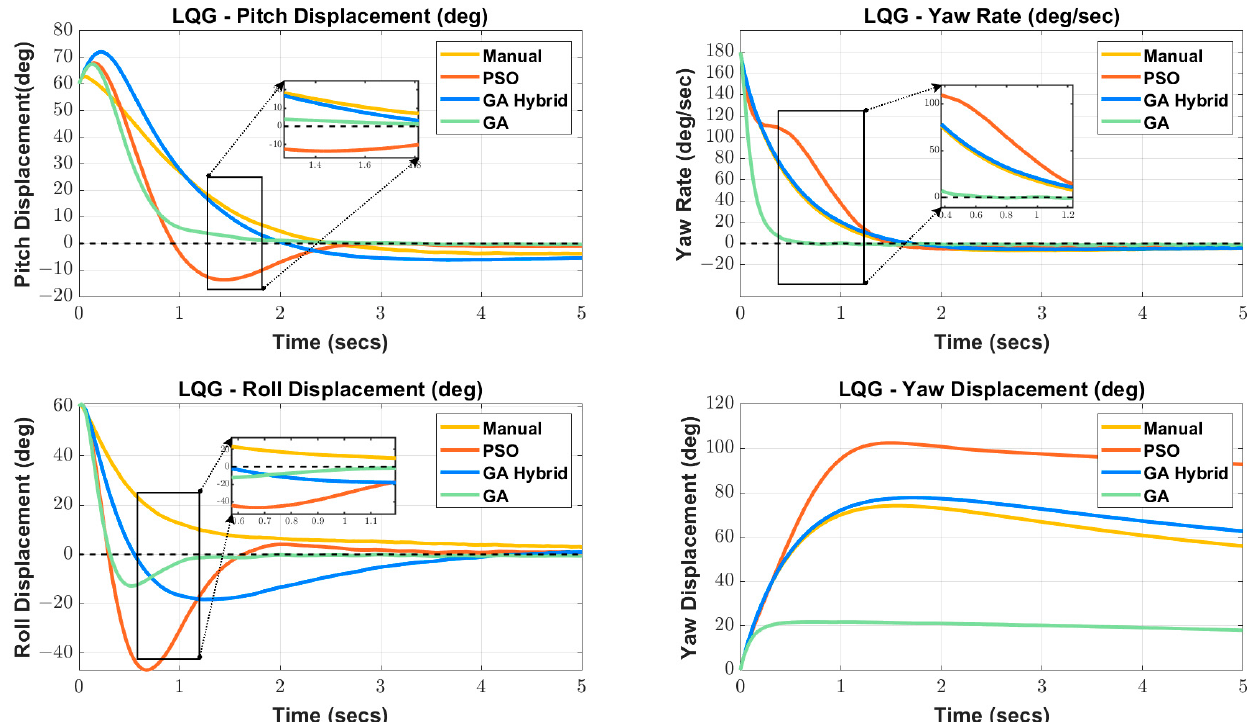
Figure 12. Full State Compensator response for Manually tuned, PSO and GA.